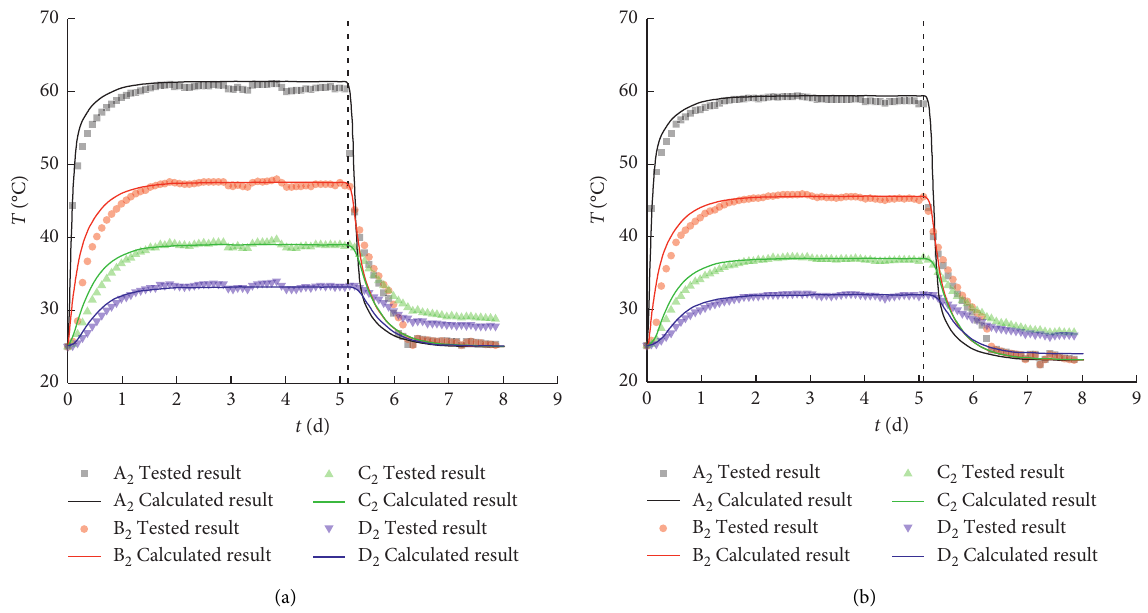
Figure 5: Comparison of results of temperature with numerical calculations in case 1: (a) α and α 2 � 1.94m − 1